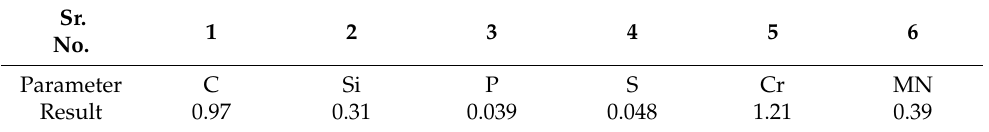
Table 1. Chemical composition of untreated pins.